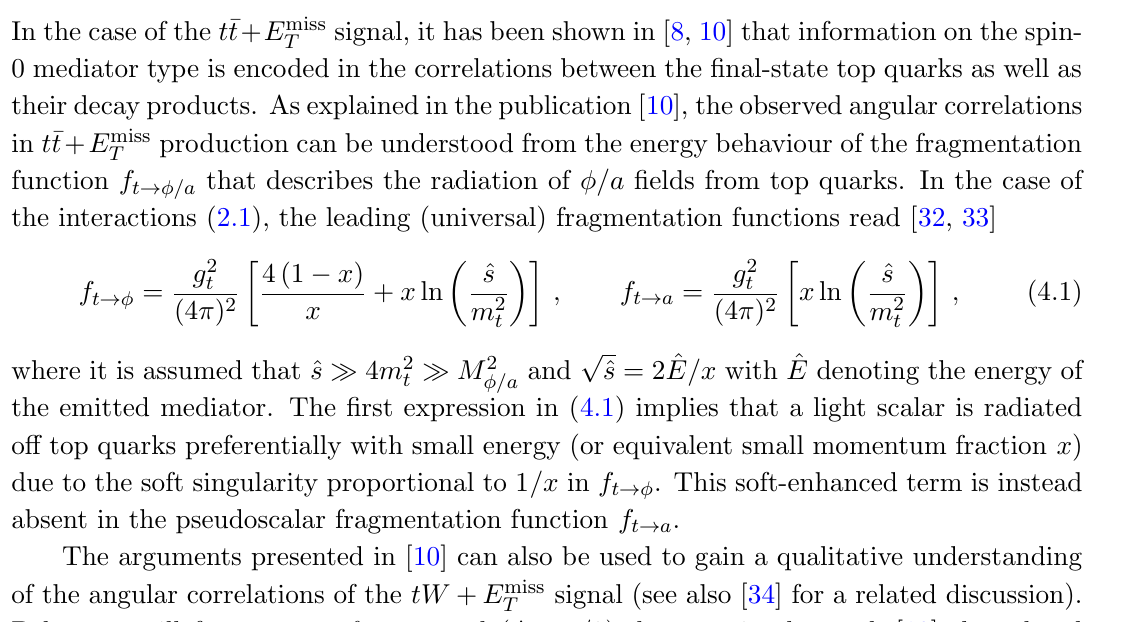
computation of the tW + E miss